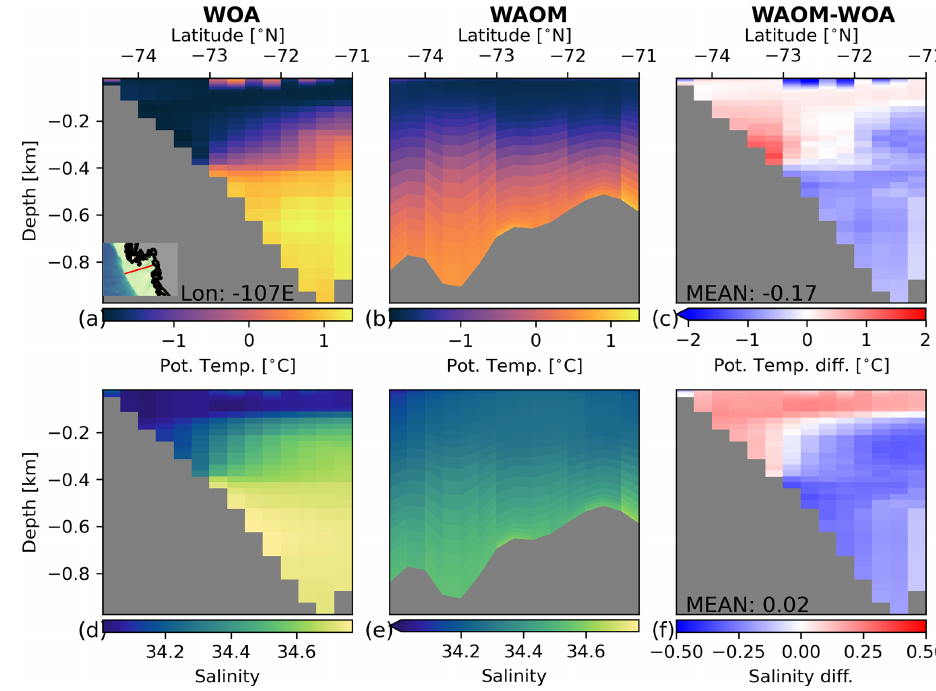
Figure 12. As Fig. 11, but for a transect across the Amundsen Sea along 107 ◦ W.